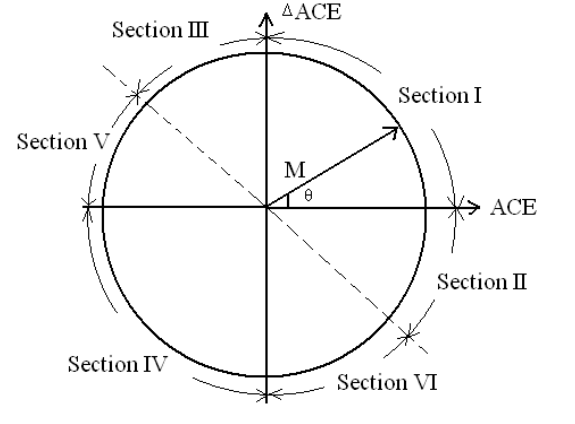
Figure 7. PF phase